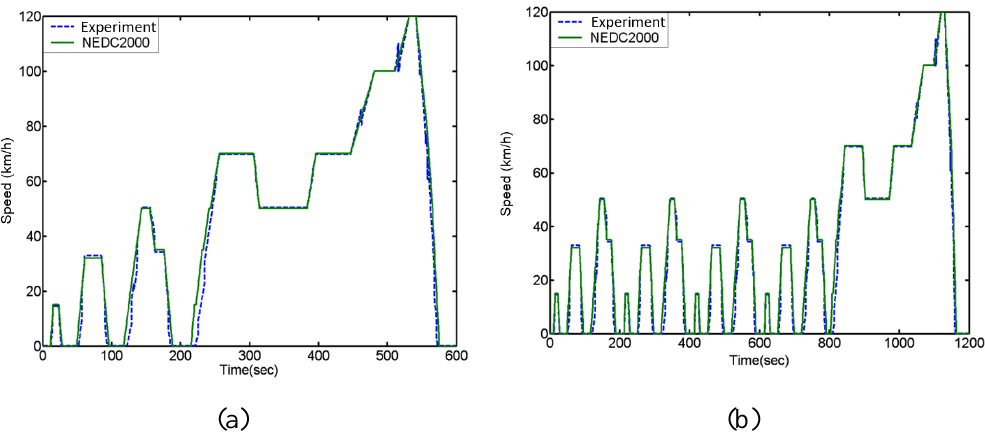
Figure 10. Comparison graphs of ( a ) experimental results and driving test patterns, ( b ) experimental results and long-term NEDC2000.